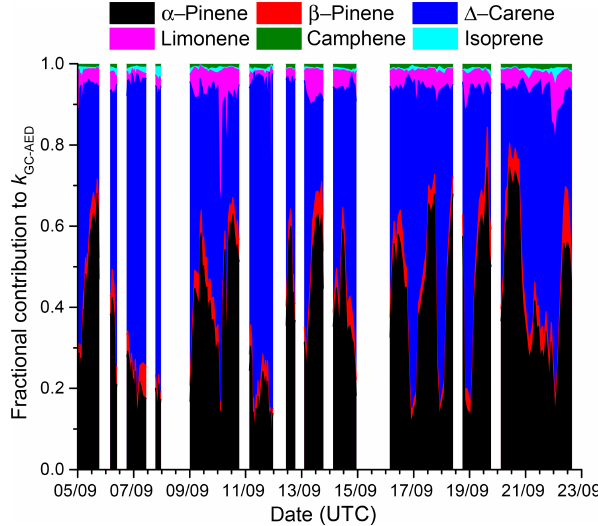
Figure 8. Fractional contribution of individual monoterpenes (mea- sured by the GC-AED) to k GC-AED indicating the dominant role of α -pinene and (cid:49)